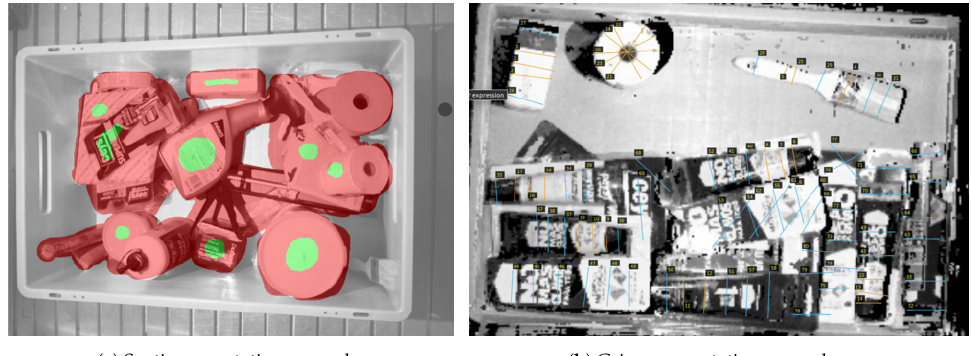
Figure 4. Annotation examples in RGB-D